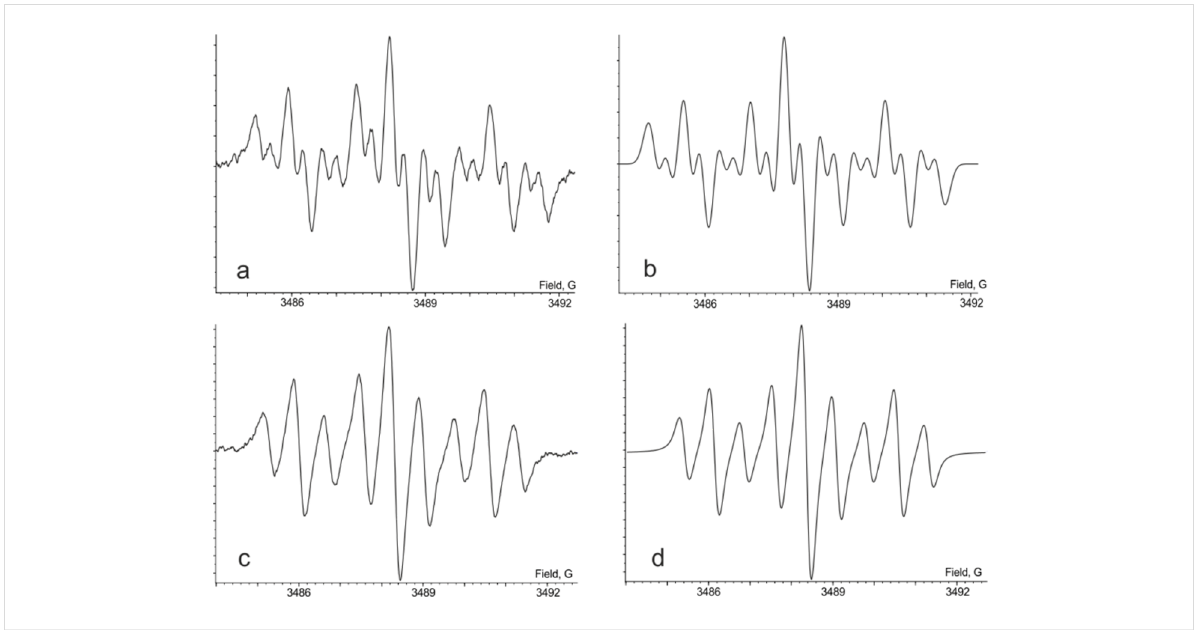
Figure 3: The EPR spectrum of (1 · )H 3 in CHCl 3 , 293 K: a) experimental, b) simulated, c) experimental + D 2 O and d) simulated + D 2 O.